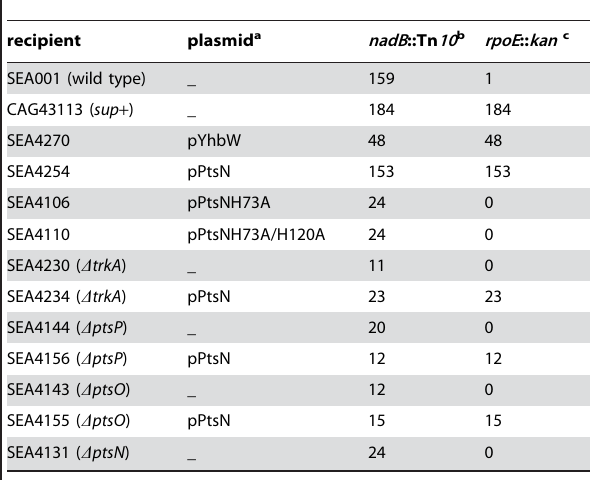
Table 2. Cotransduction of nadB ::Tn 10 and rpoE :: kan